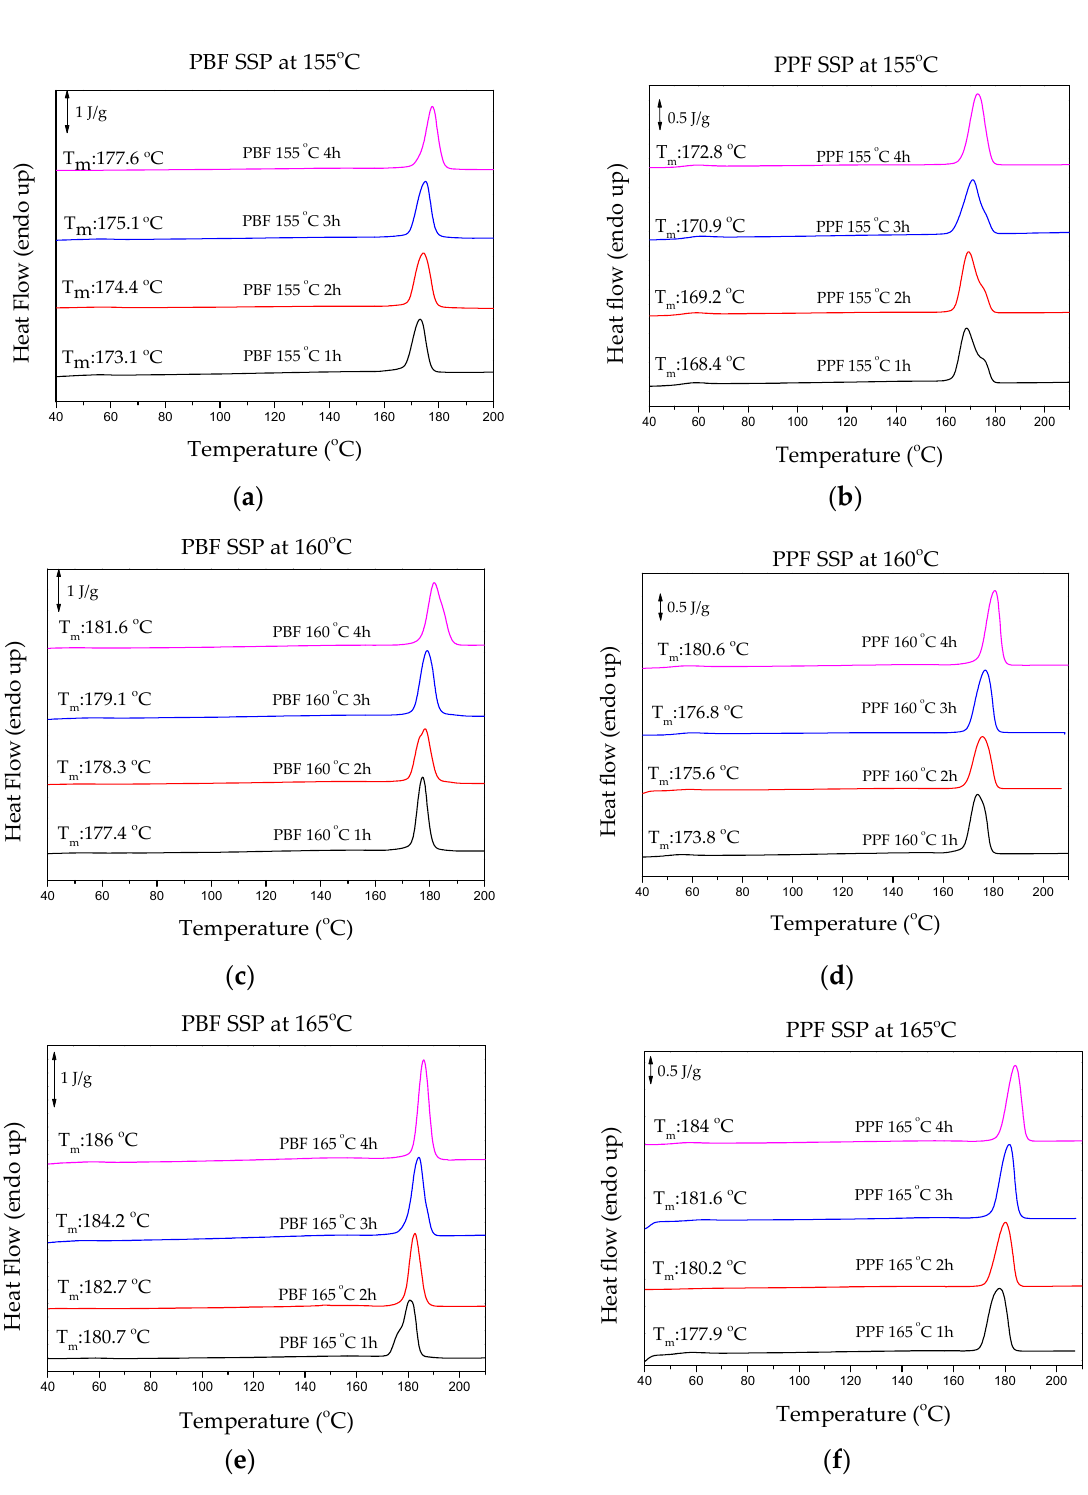
Figure 8. DSC thermograms of the prepared polyesters after SSP at 155 °C for ( a ) PBF, ( b ) PPF, after SSP at 160 °C for ( c ) PBF, ( d ) PPF and after SSP at 165 °C for ( e ) PBF, ( f ) PPF.